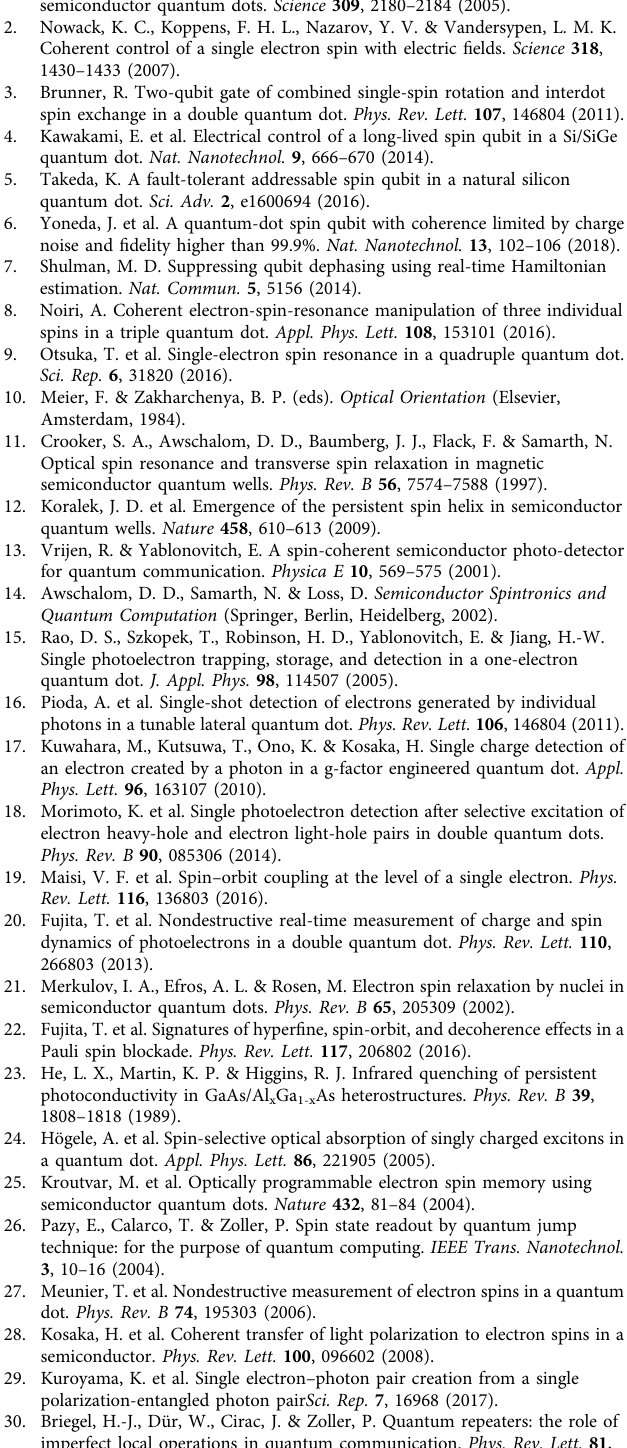
Fig. 1b. The current through the charge sensor, I sensor , detects the change in the charge con fi guration due to the event of photo-electron trapping in the DQD with a response time of 100 μ s or less. Photon pulses with width of 3ps are produced from a wavelength-tunable Ti:sapphire laser, and irradiated onto left dot through a 400-nm-diameter aperture in the metal mask. The device is placed in an optically accessible dilution refrigerator with base temperature of 25 mK. The QW wafer used here has a 7.3-nm-thick GaAs QW layer between a 95nm-thick Al 0.34 Ga 0.66 As barrier layer above and a 100-nm-thick Al 0.34 Ga 0.66 As barrier layer beneath. The bottom thick barrier avoids excess photo-electrons coming from a thick GaAs buffer beneath the QW. An external magnetic fi eld B is applied in the out-of-plane direction to the DQD device. The electron g -factor of the QW estimated for this fi eld direction is | g ⊥ | = 0.12 32 (see Supplementary Note 1 and Supplementary Fig. 1 for more details about the electronics and